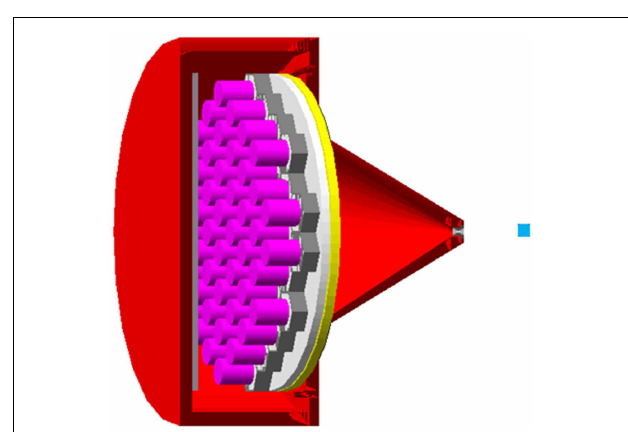
FIGURE 1 | Gate modeling of the GE400AC equipped with the MEPH collimator . From right to left: blue: perpex surrounding the 90 Y point source, gray: 6mm-aperture tungsten insert, red: lead housing, yellow: 1/2 (cid:48)(cid:48) -thick NaI crystal, white: 12mm-thick pyrex light guide, gray: 0.2mm-thick hexagonal mu-metal shielding, purple: cathode–dynode cascade (PMTs pyrex housing was set no visible), gray: 1cm-thick perpex modeling the